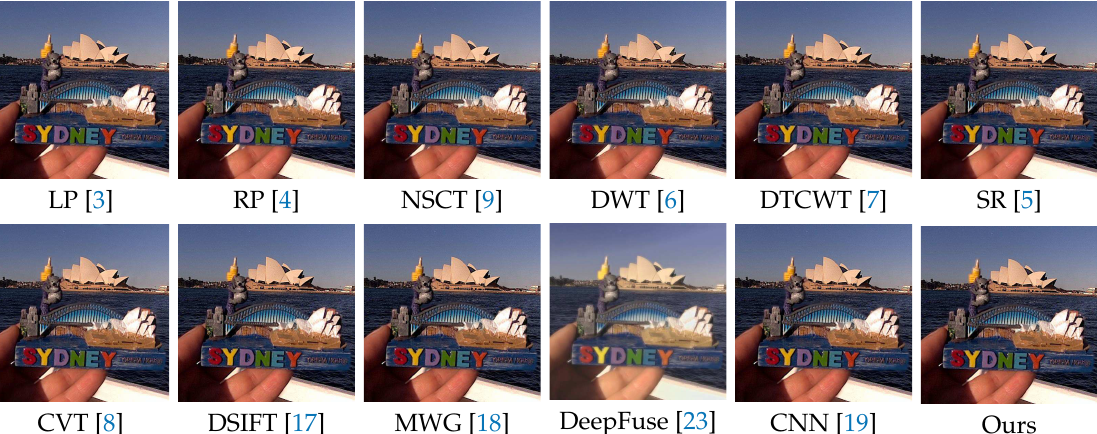
Figure 9. The results of ’Lytro-14’ using various methods.